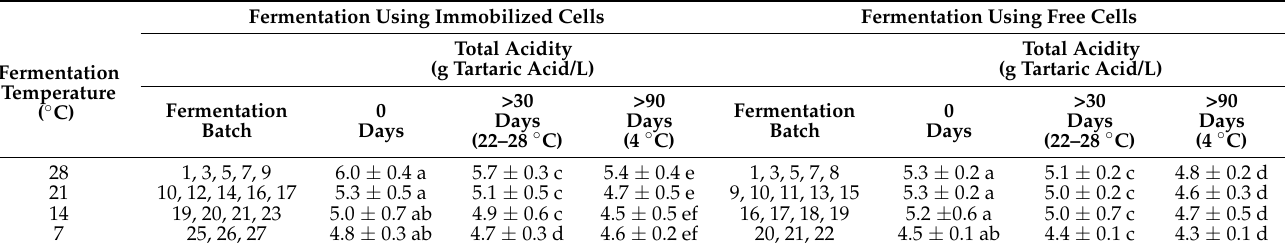
Table 9. Total acidity of wines produced from must (12.5 ◦ Be) using immobilized and free cells at 28, 21, 14 και 7 ◦ C and analyzed after storage at 22–28 ◦ C and 4 ◦ C of their production.